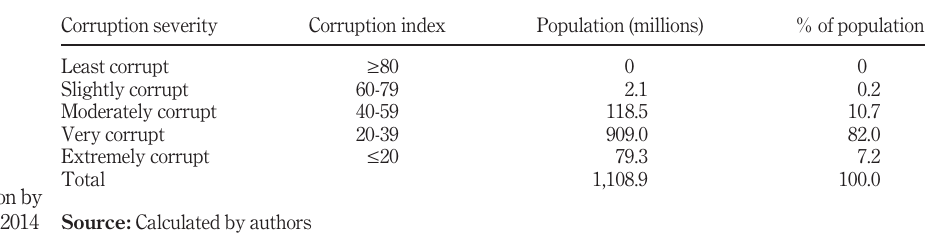
Table III. African corruption by level of severity,